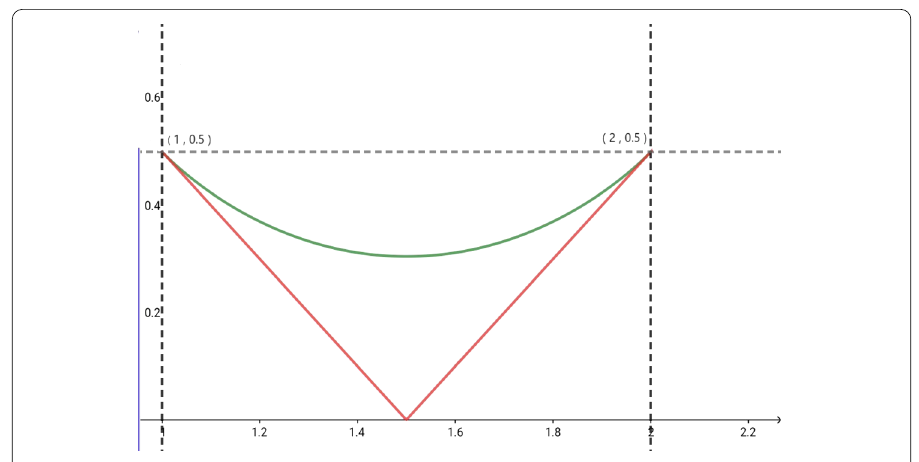
Figure 2 The graph of the result in Example